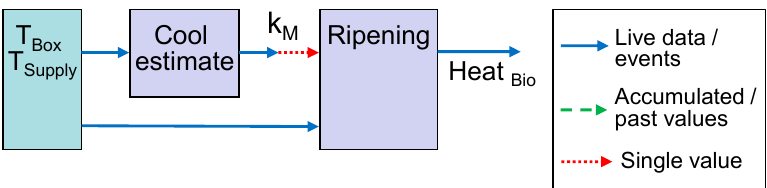
Figure 3. Model linking for estimation of ripening heat based on parameter k M for cooling efficiency.